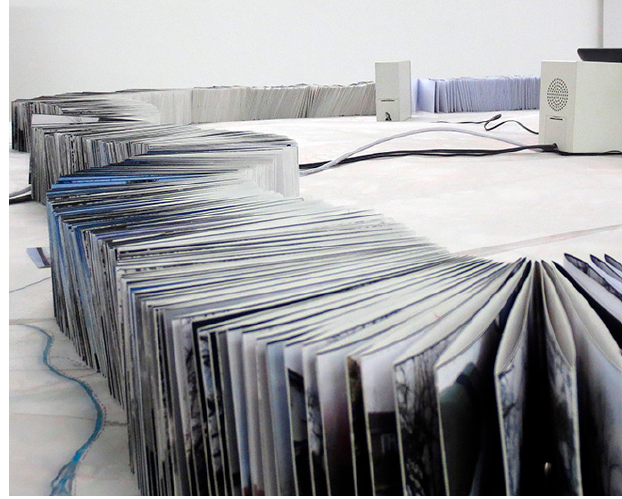
Figure 4. The Author, The M25 in 4000 Images (2014). Inkjet on matte paper, cut, folded, and constructed by hand. Edition of 1. Shown as an installation with constructed map and drawing/planning document and online replay of The Great Orbital Run , with sound (detail). Photo: The Author.